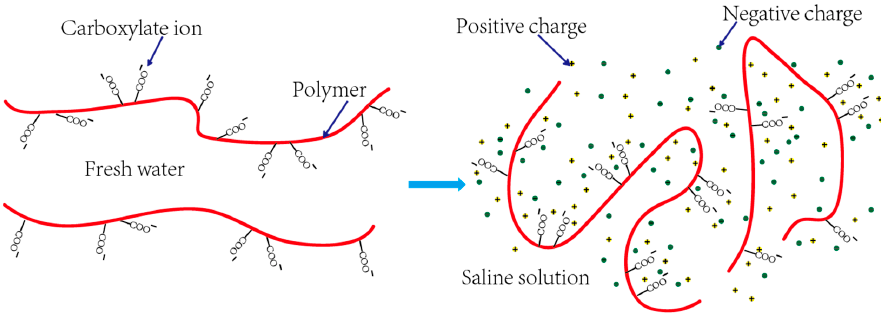
Figure 7. Electrostatic shielding of polymer in NaCl/KCl solution.